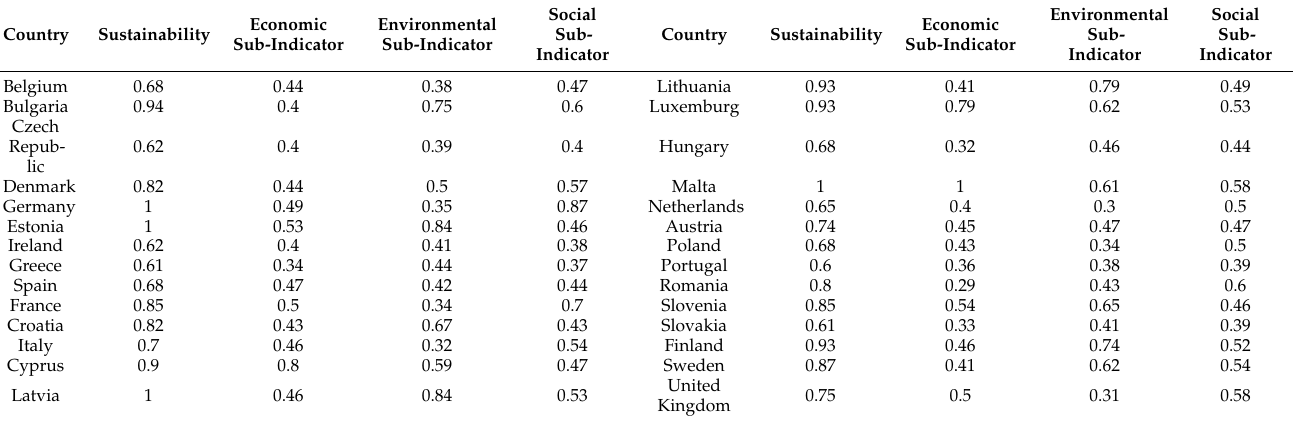
Table 3. Results for the construction of a sustainability composite